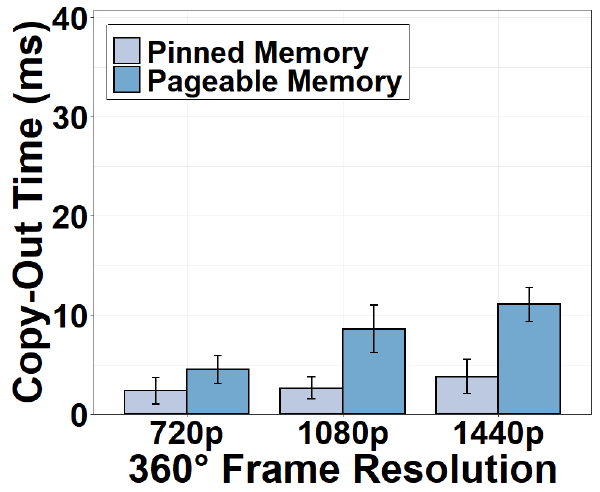
Figure 5. Copy-out time using different memory